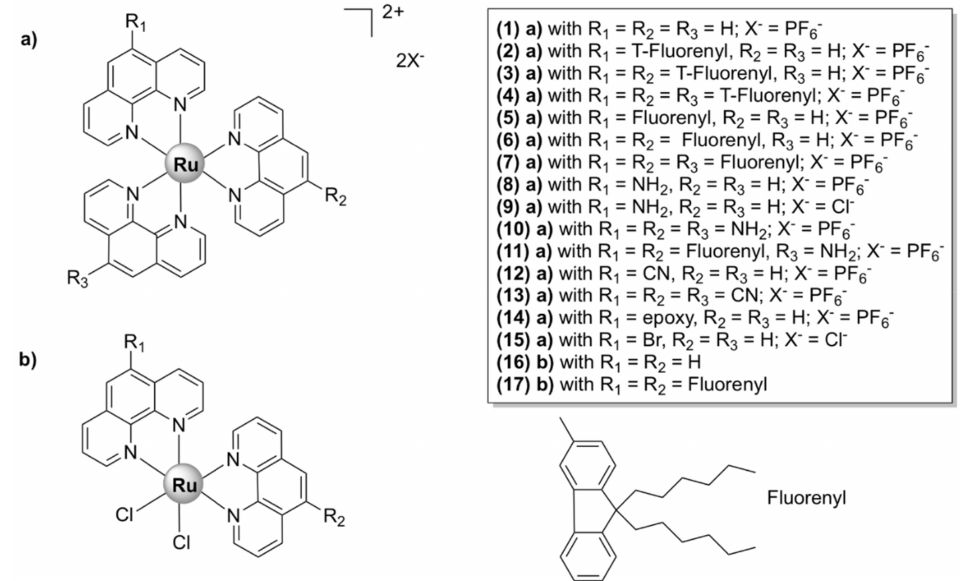
Figure 21. Chemical structures of the homo- or heteroleptic polypyridyl Ru(II) complexes (1) – (17) with the general formulae [Ru(Phen) 3 ](PF 6 ) 2 , [Ru(Phen) 2 (Phen-X)](PF 6 ) 2 , [Ru(Phen)(Phen-X) 2 ](PF 6 ) 2 , [Ru(Phen-X) 3 ](PF 6 ) 2 , [Ru(Phen-X) 2 Cl 2 ], or [Ru(Phen) 2 Cl 2 ]. The core structures of the complexes (1) – (17) correspond to either ( a ) or ( b ), as denoted in the top right corner of the figure. The fluorene unit was bonded to the 1,10-phenanthroline moiety ligand either directly (Fluorenyl, bottom right corner) or via a triple bond